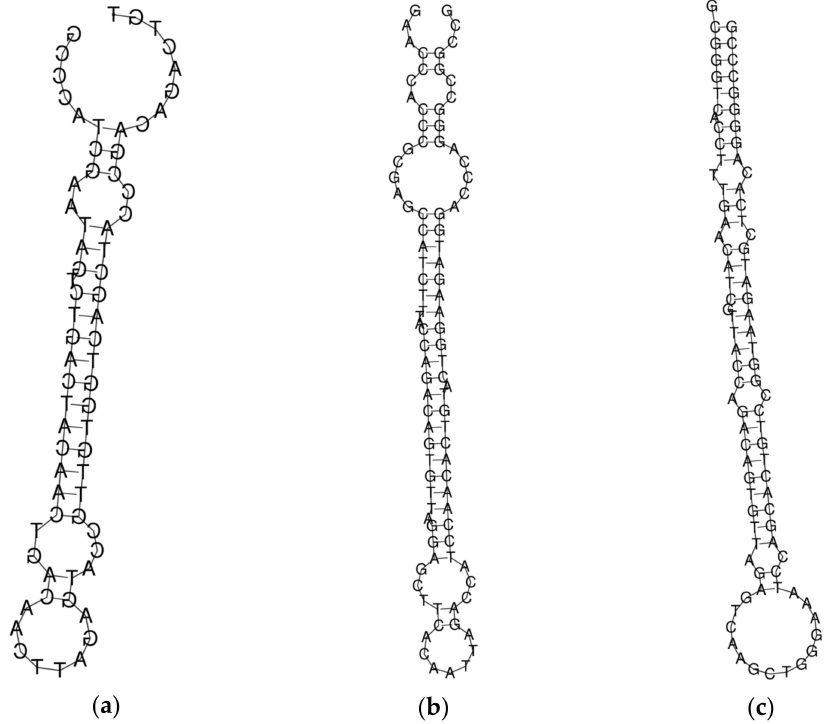
Figure 1. The structure of molecular probes probe_1 ( a ), probe_2 ( b ), and probe_3 ( c ) obtained using the RNAfold source (http://rna.tbi.univie.ac.at/cgi-bin/RNAWebSuite/RNAfold.cgi; accessed on 8 December